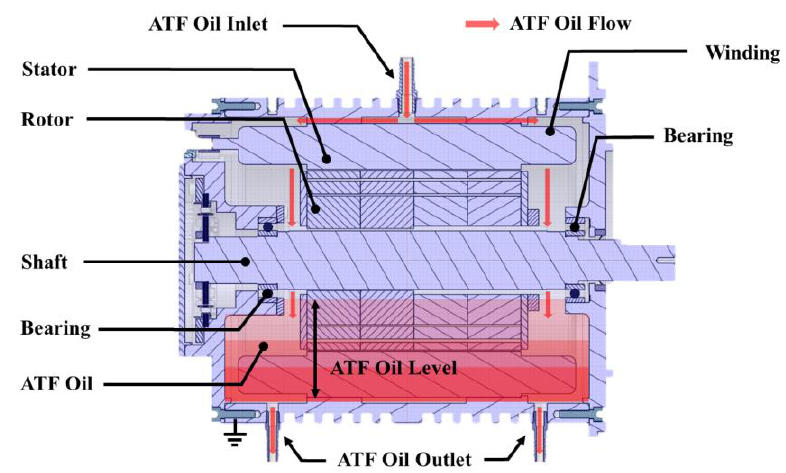
Figure 10. Flow channel for oil spray cooling method by [78].